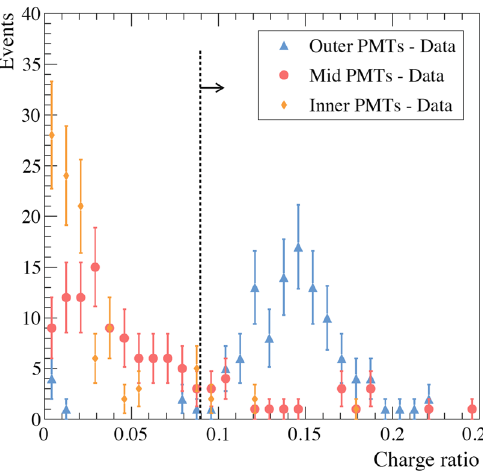
Fig. 8 Ratio of charge in a prompt, 5 ns window to the total charge for each hit PMT for pure